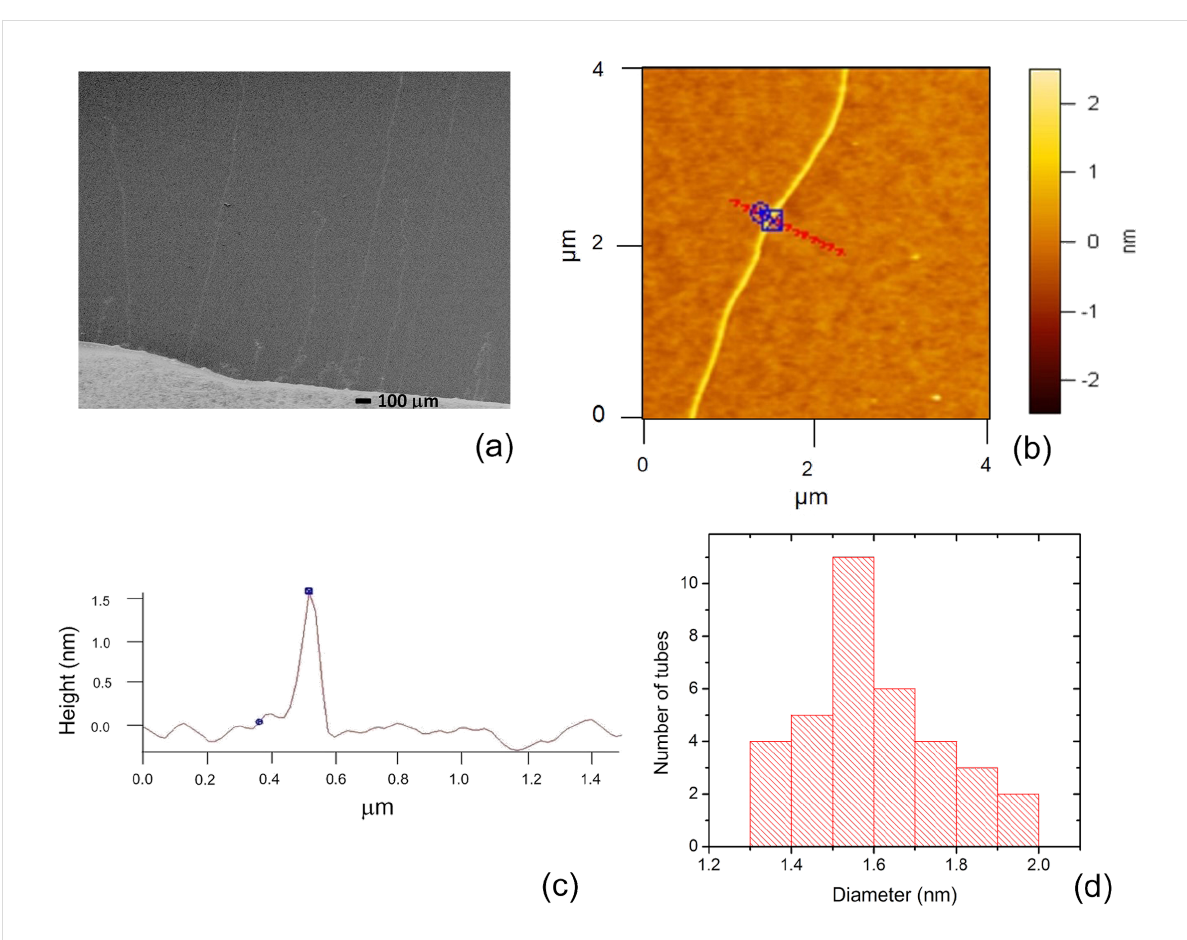
Figure 1: (a) SEM image of long CNTs grown by the CVD process. (b) AFM image and (c) height profile of a long individual SWCNT with a diameter of ≈ 1.51 nm. (d) A histogram plot of the diameter distribution of the as-grown